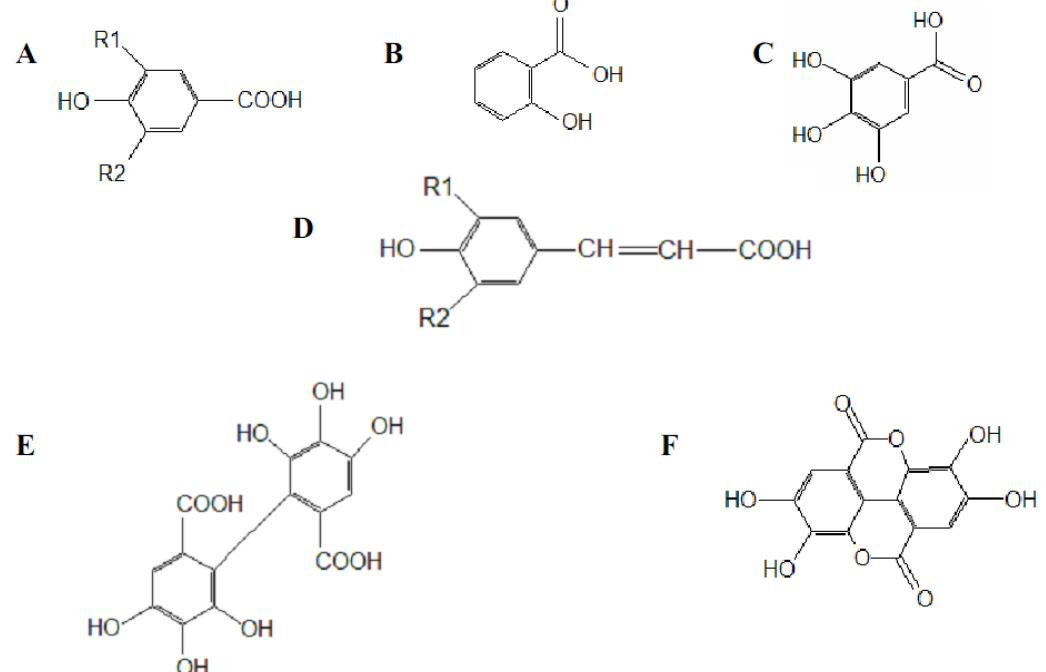
Figure 1. (A) p -Hydroxybenzoic; R1= R2=H, vanillic; R1= methoxy group, R2=H, protocatechuic acid; R1= OH, R2=H and syringic acid; R1= R2 = methoxy group. (B) Salicylic acid. (C) Gallic acid. (D) p -Coumaric acid; R1= R2 = H, caffeic acid; R1= OH, R2 = H, ferulic acid; R1= methoxy group, R2 = H and sinapic acid; R1= R2 = methoxy